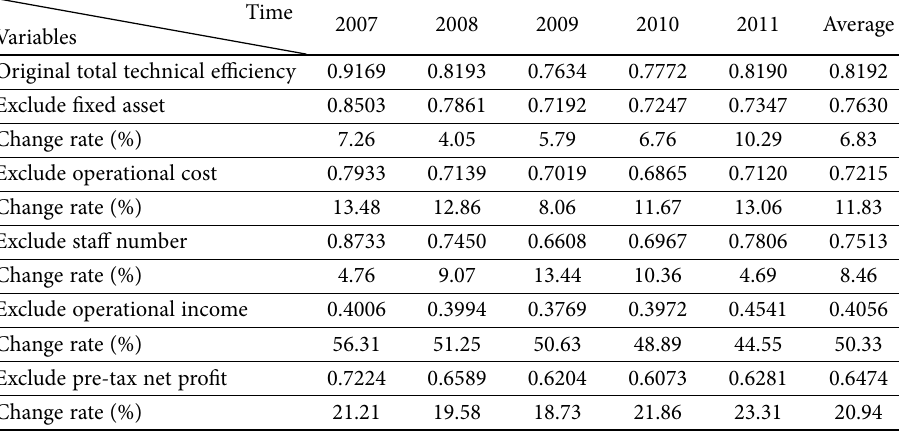
Table 9. 2007–2011 Input output sensitivity